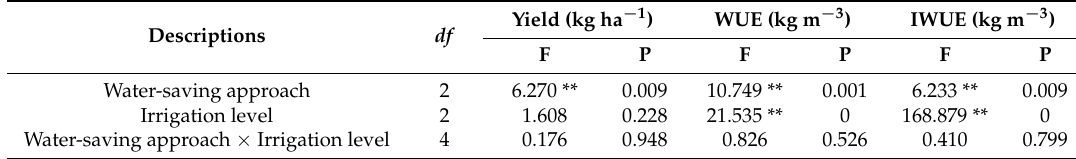
Note: F represents F-statistics; P represents significant value. ** means the significant difference at the level of 0.01.